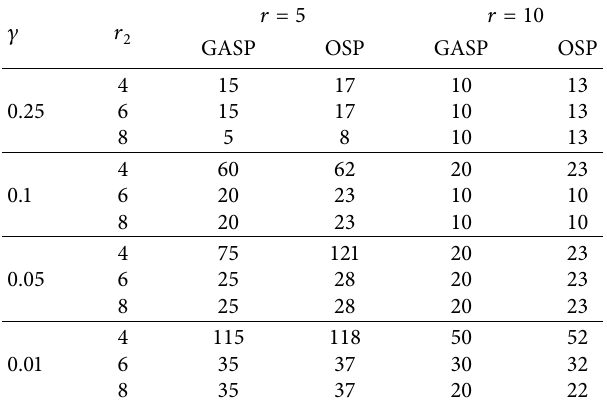
Table 5: Sample sizes of GASP and OSP when 􏽢 β � 0 . 5 and 􏽢 θ � 42. r � c r 2